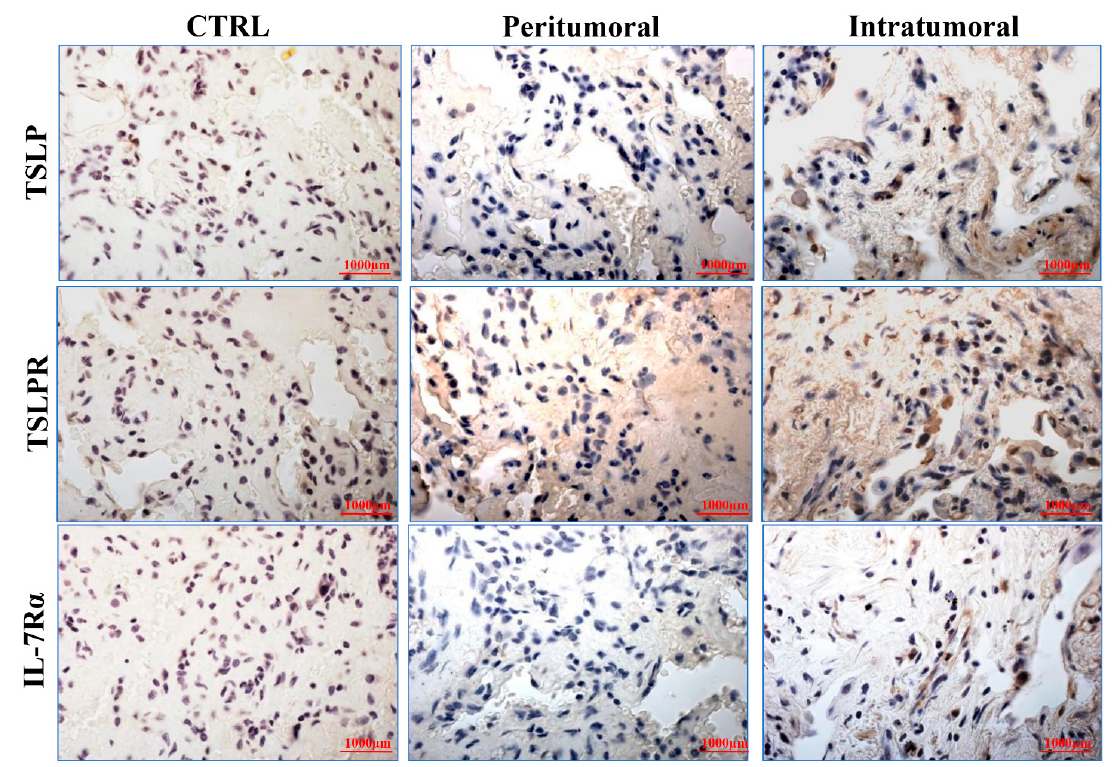
Figure 7. Expression of TSLP, TSLPR, and IL-7R α in peritumoral and intratumoral human lung cancer by immunohisto- chemistry. Immunohistochemical staining for TSLP, TSLPR, and IL-7R α in peritumoral and intratumoral human lung cancer. In the control (CTRL), the primary antibody was omitted. Microscope magnification 20 × . This experiment is representative of 5 experiments obtained from different patients.